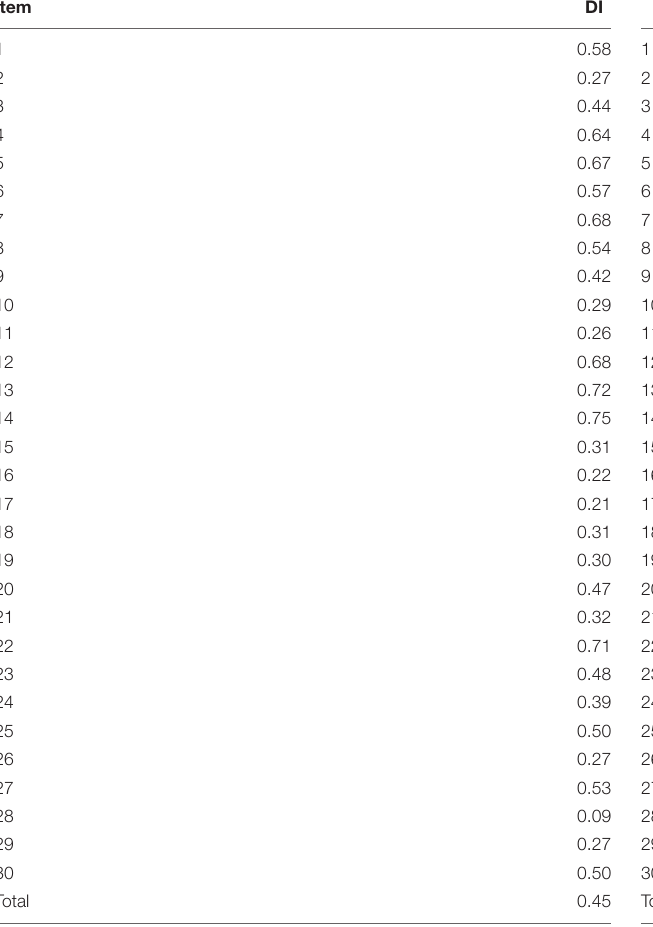
TABLE 3 | Difficulty Index for items in the BECOMA On.